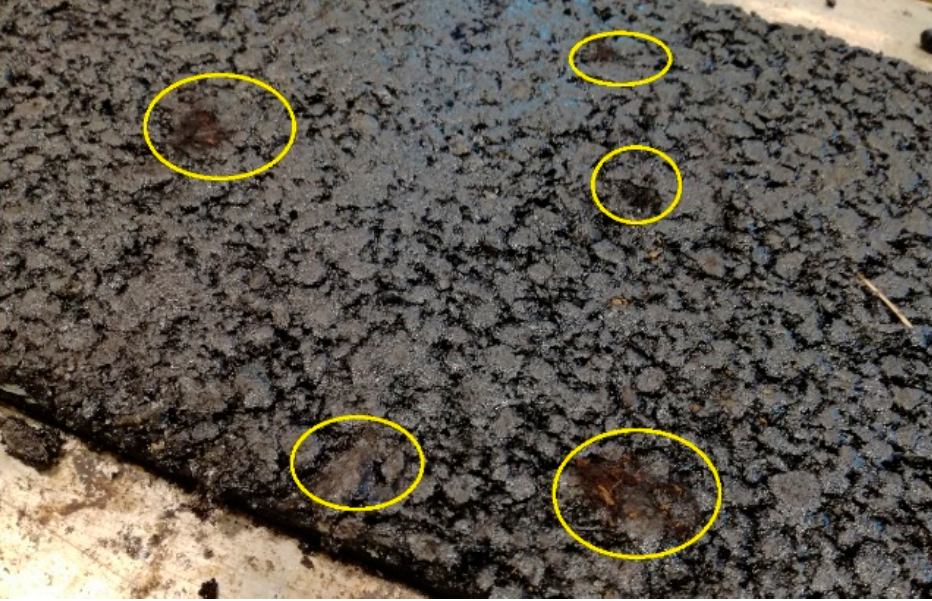
Figure 16. An example of an asphalt slab produced by the dry approach (mixing peat with aggregates in the asphalt mix).